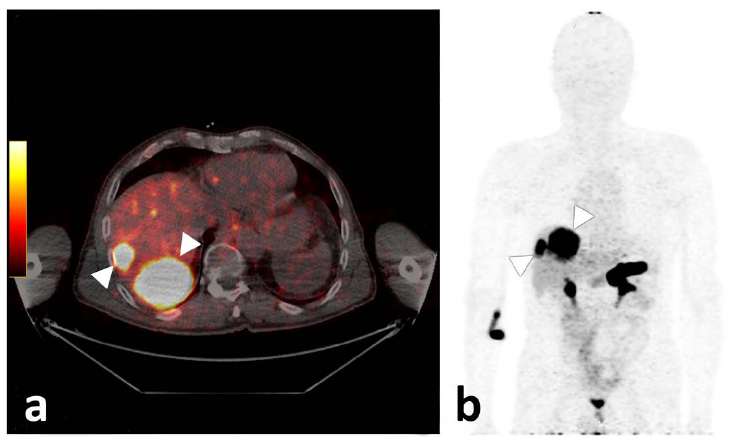
Figure 5. Axial fused PET/CT image of participant 3, demonstrating two liver metastases with high tracer uptake ( a ). On the ( b ), the corresponding maximum intensity projection is given, also demon- strating strong physiologic pancreatic as well as rectal and diffuse small bowel tracer accumulation.